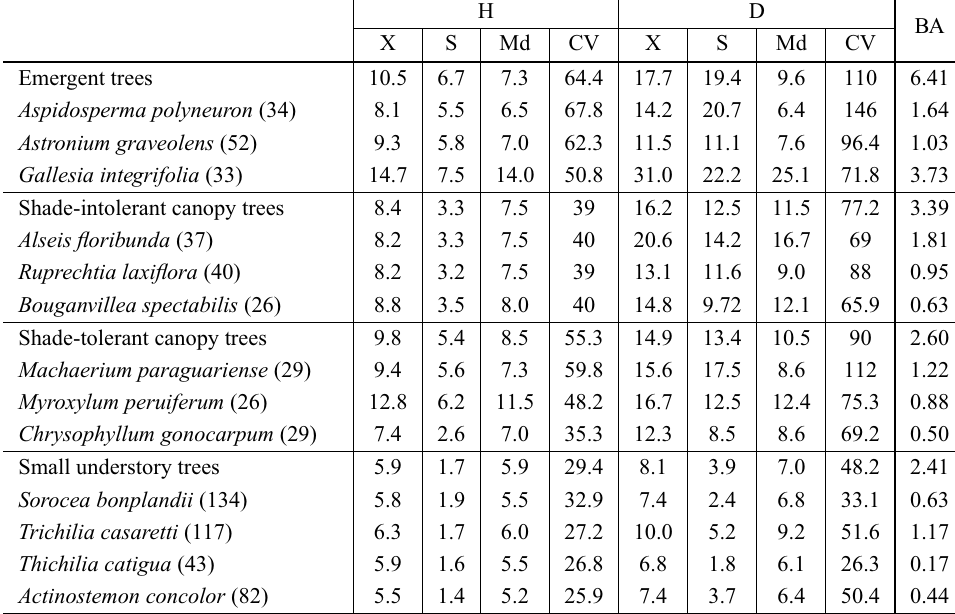
Height, diameter and basal area data for a sample of tree species in a riparian forest fragment in Fazenda Doralice, Ibiporã, Paraná State, Brazil. H – height (m); D – diameter